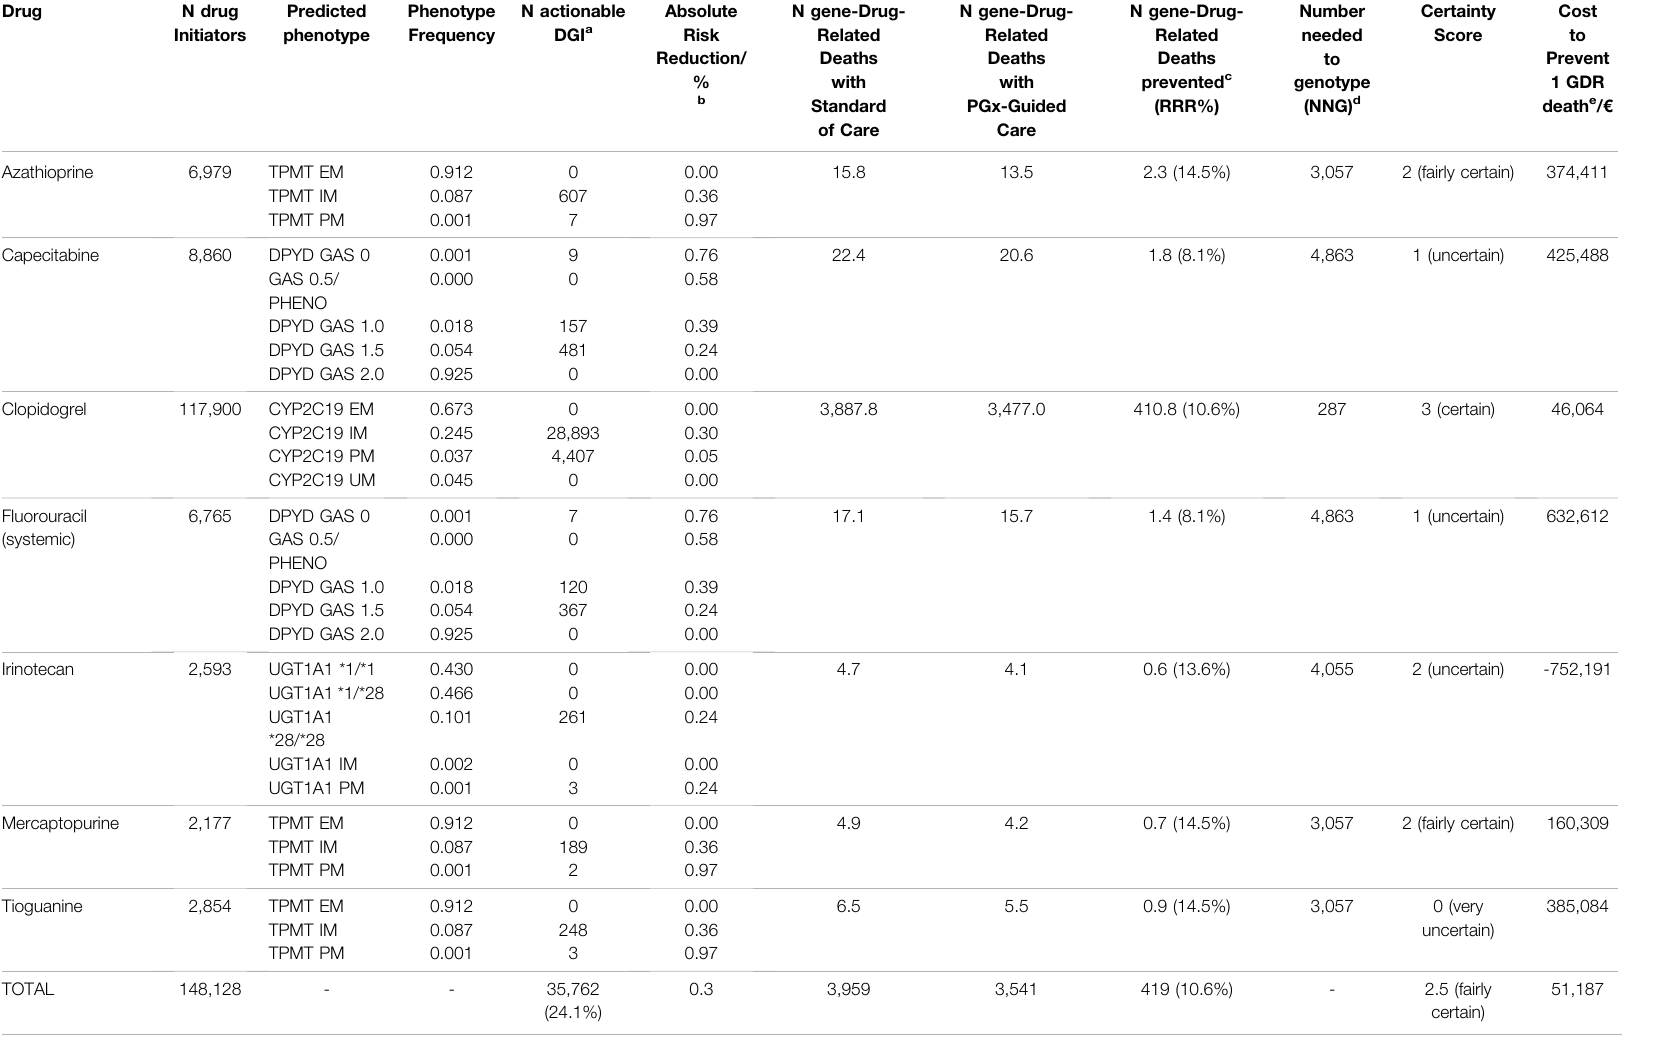
TABLE 3 | Cost-effectiveness of PGx-guided pharmacotherapy for gene-drug interactions to prevent gene-drug-related deaths.